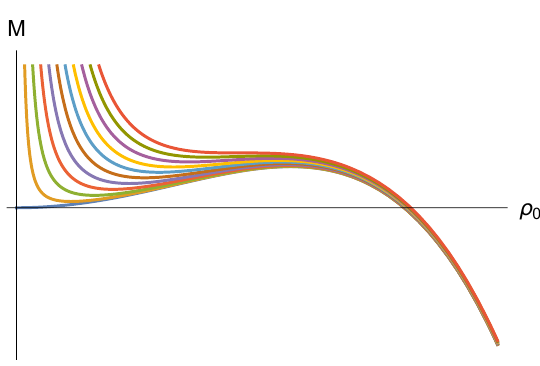
Figure 1 . The energy (eq. (2.8)) of a one-parameter family of initial data labeled by bubble radius (cid:26) 0 . From bottom to top, curves correspond to Q = 0 ; : : : ; Q = Q max . The most stable bubbles lie at small Q ; for Q > Q max , no stable solution